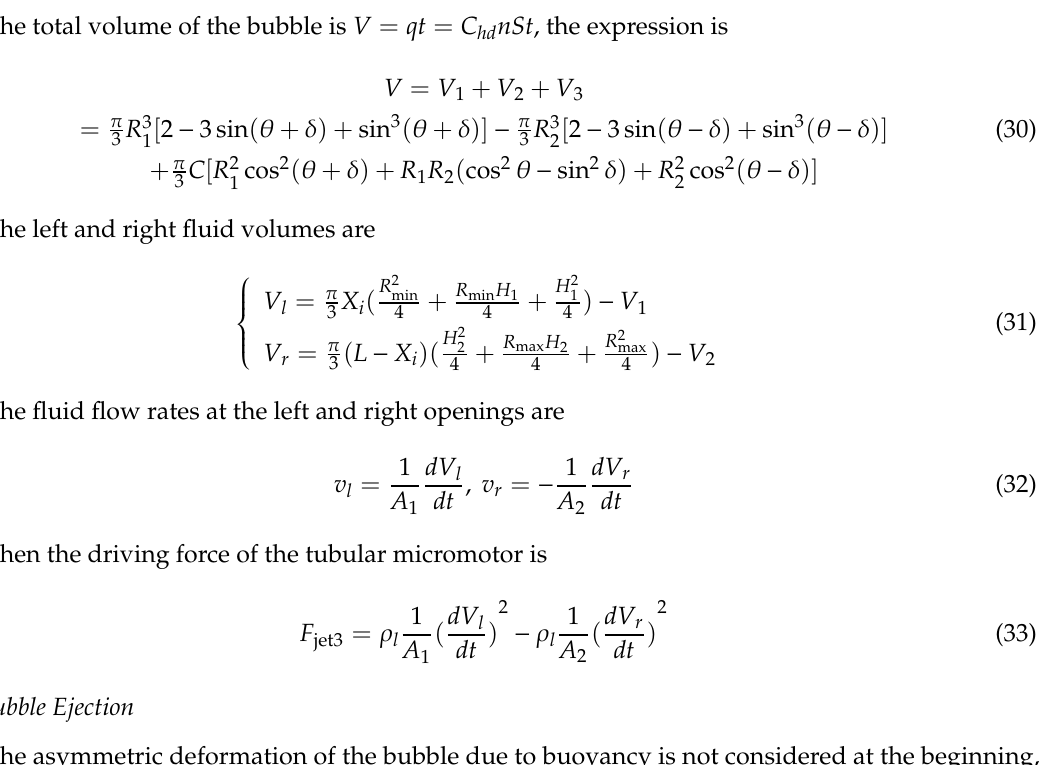
Figure 4. The contact of the bubble with the inner wall of the micromotor. ( a ) The volume of several parts as the bubble is in full contact with the inner wall of the micromotor. ( b ) The geometry of the bubble and the forces it experiences.